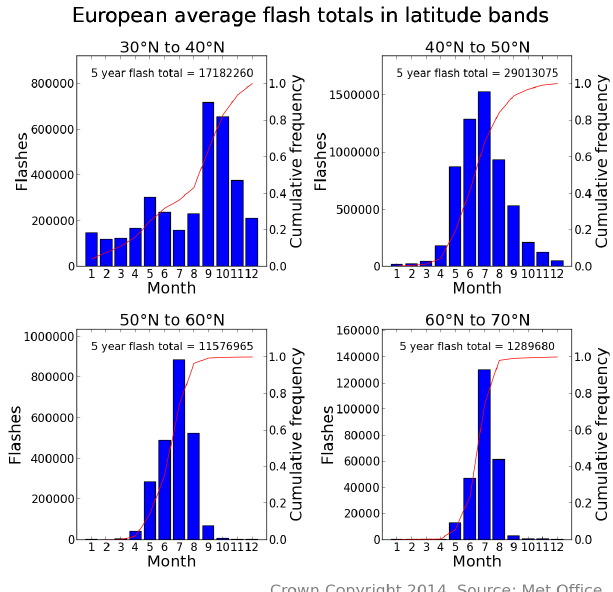
Fig. 19. Detected lightning flash density for July for Genoa.